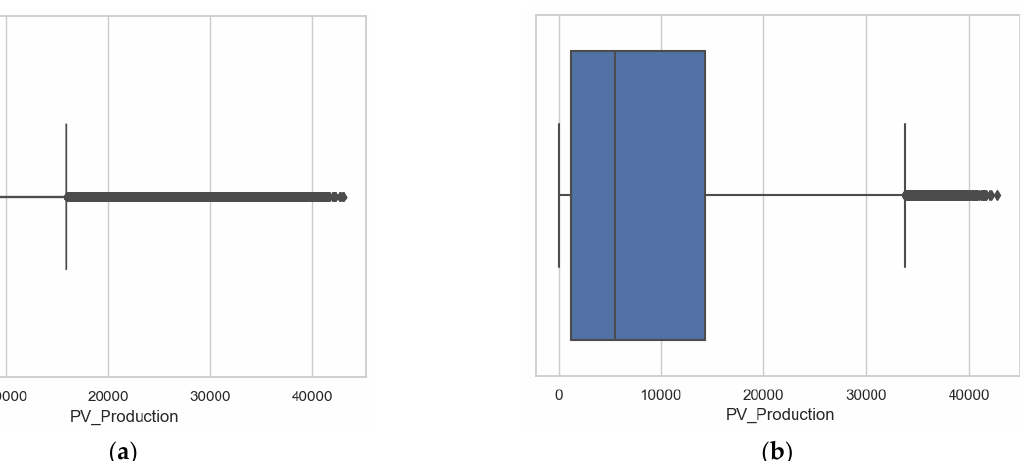
Figure 3. Boxplot of the PV production ( a ) with null production and ( b ) removing those 0 Wh samples.